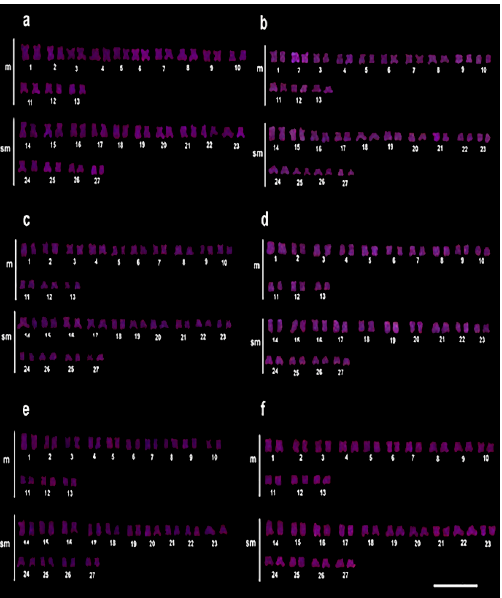
Figure 4. Chromosomal mapping of the Rex 6 by FISH in C. macropomum. ( a ) FISH in the control group (C0 = 0.0 mg/L of Trichlorfon), ( b ) 30% LC 50–96 h -48 h of Trichlorfon (C1 = 0.261